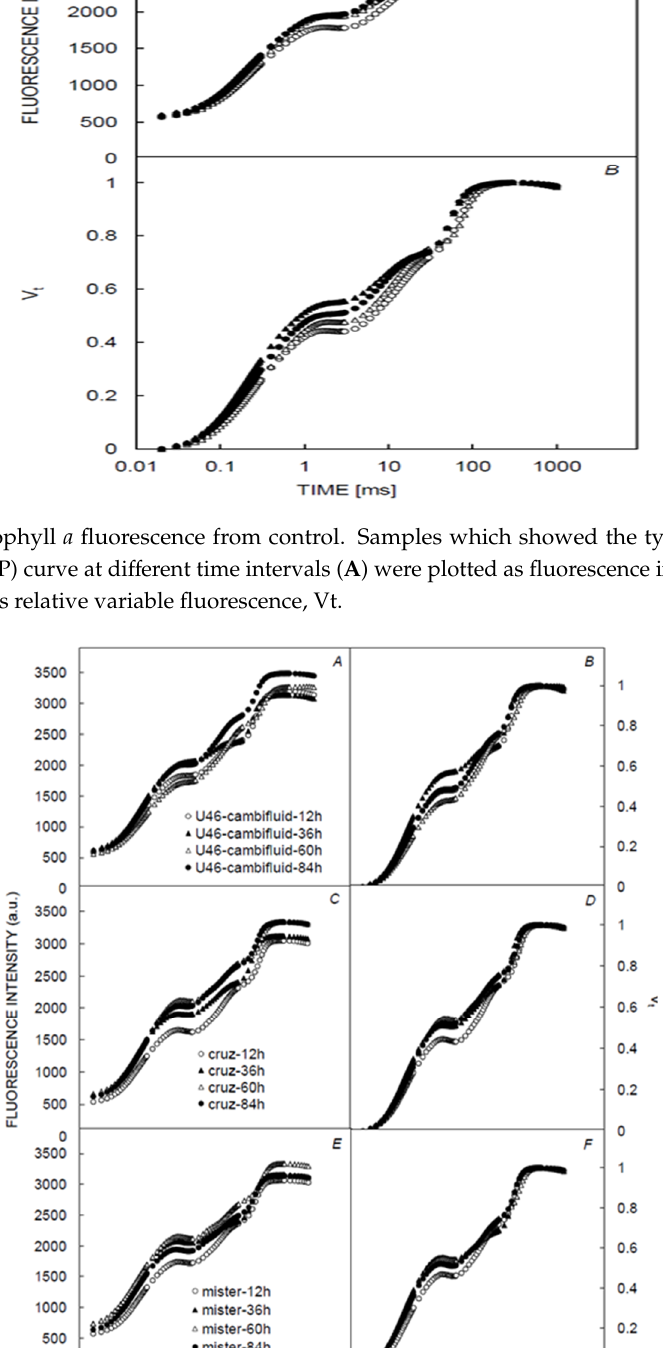
Figure 3. Effect of herbicides on OJIP fluorescence rise kinetics. Effects of different herbicides on OJIP fluorescence rise kinetics analyzed by calculating the difference in the variable fluorescence curves (  Vt) at different time intervals.